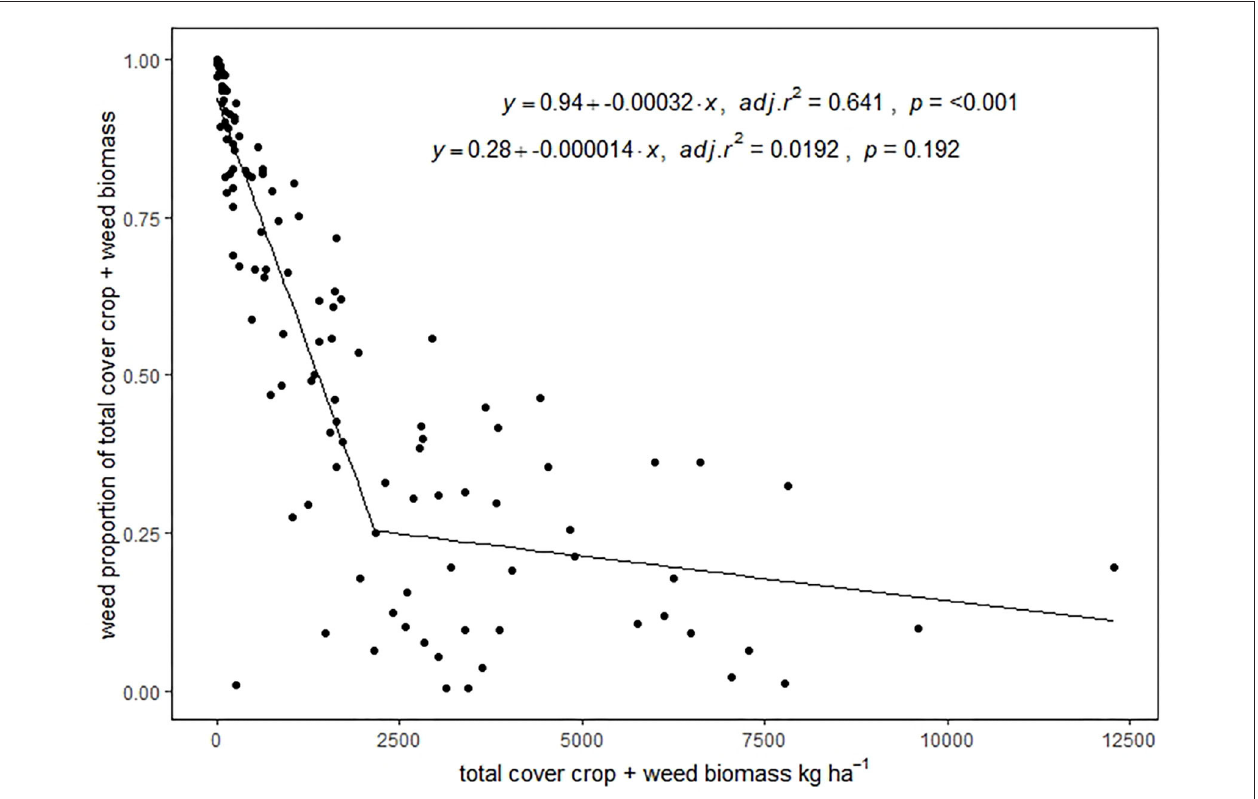
FIGURE 2 | Relationship between total biomass and percentage of biomass from weeds. Best fit model chosen from linear, quadratic, and linear plus plateau, with equations for each of the two lines. The top equation represents the line from 0 to 2,169 kg ha − 1 , and the bottom equation represents the line > 2,169 kg ha − 1 .